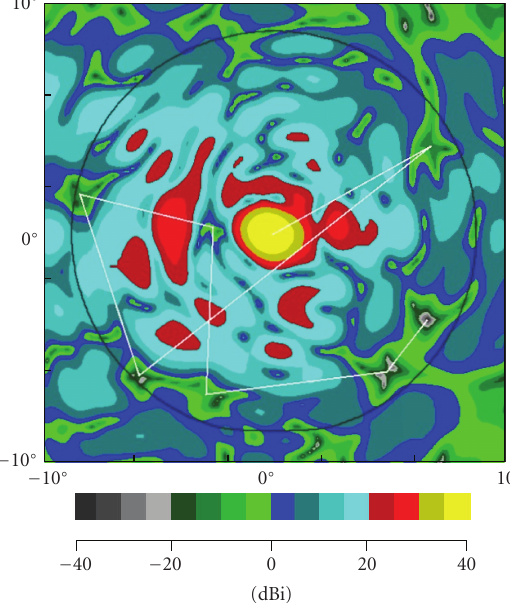
Figure 5: Synthesised beams with nulls, with errors.